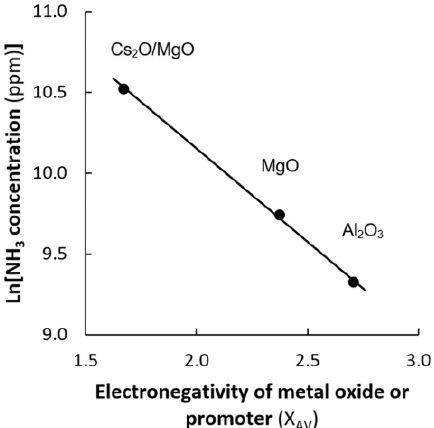
Figure 5. Ammonia synthesis rate as a function of the electronegativity for plasma-catalytic ammonia synthesis. Reproduced from [38].